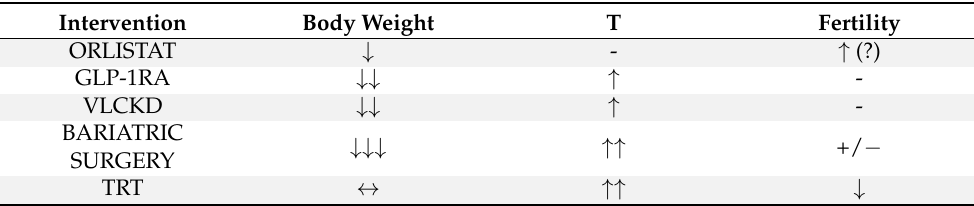
Table 1. Effects of different approaches for obesity treatment and for hypogonadal hypogonadism on testosterone levels and fertility. Intervention Body Weight T Fertility ORLISTAT ↓ - ↑ (?) GLP-1RA ↓↓ ↑ - VLCKD ↓↓ ↑ - BARIATRIC SURGERY